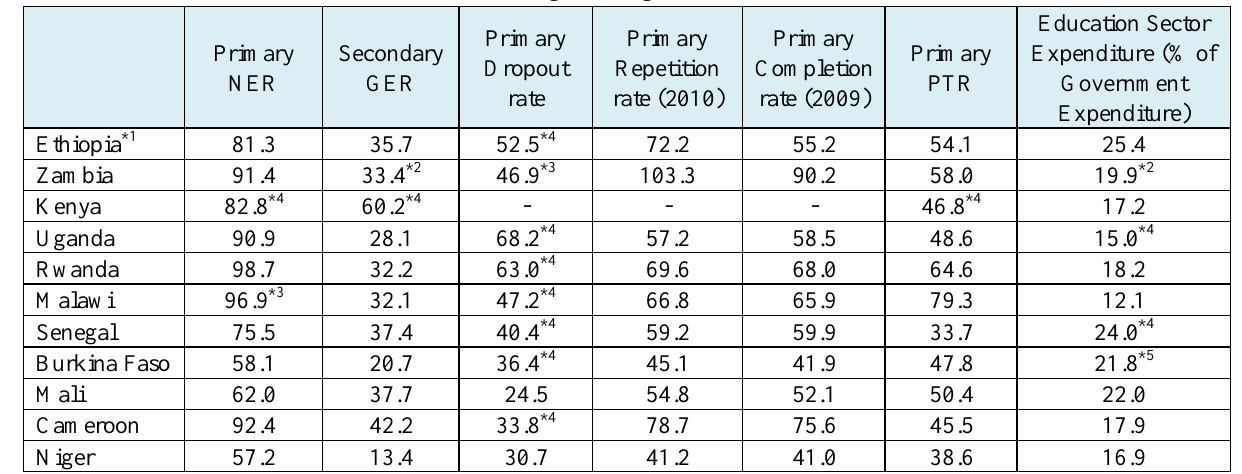
Table 7-1 : Comparison of Education Indices of Ethiopia and 10 Neighboring Countries